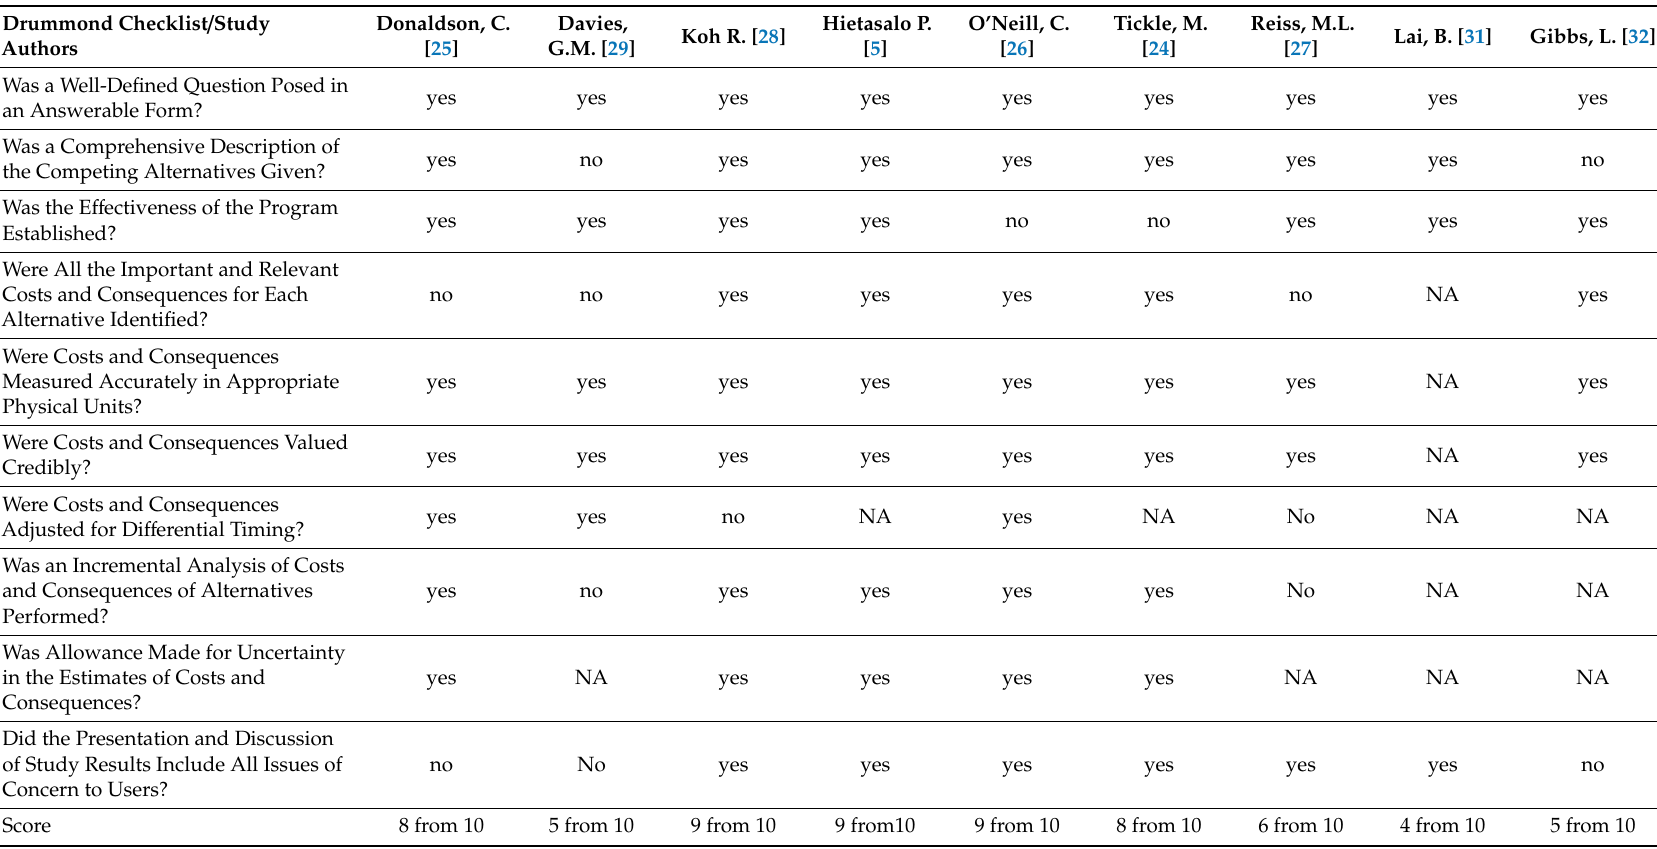
Table A4. The Drummond checklist for the risk of bias assessment of the model-based economic evaluation